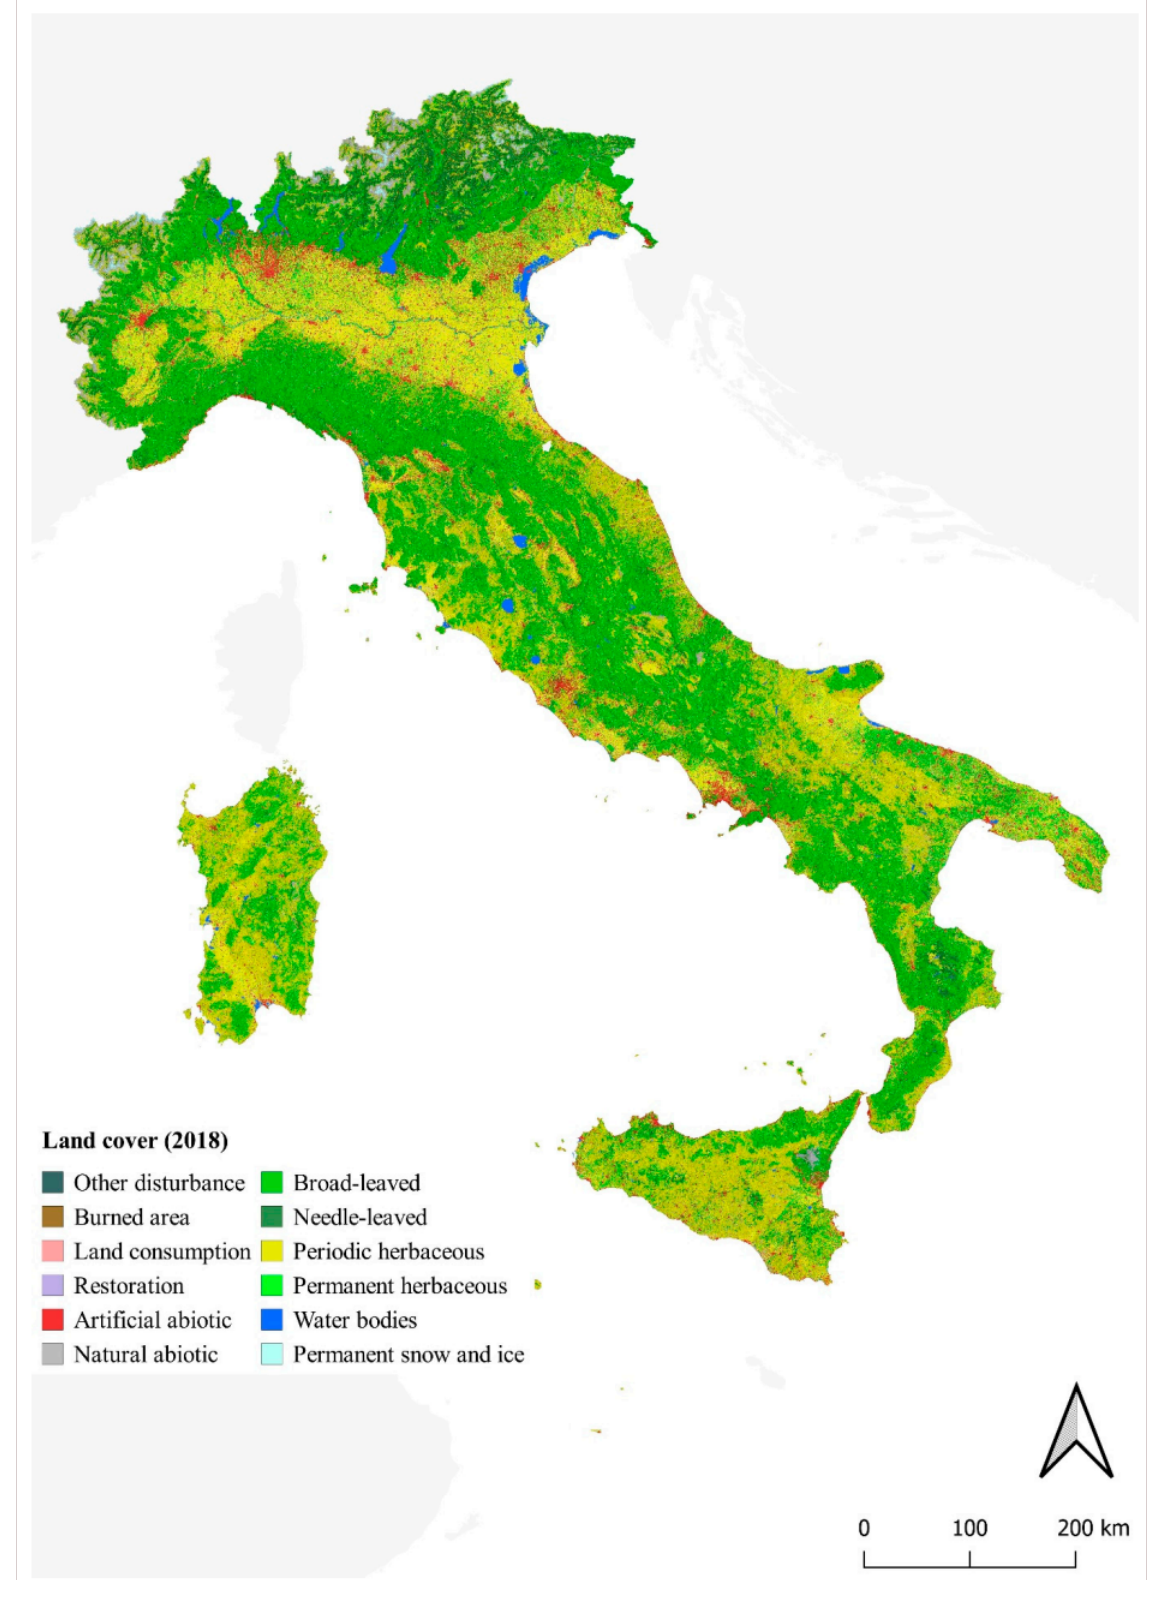
Figure 3. Land cover 2018 and land cover change 2017–2018 in